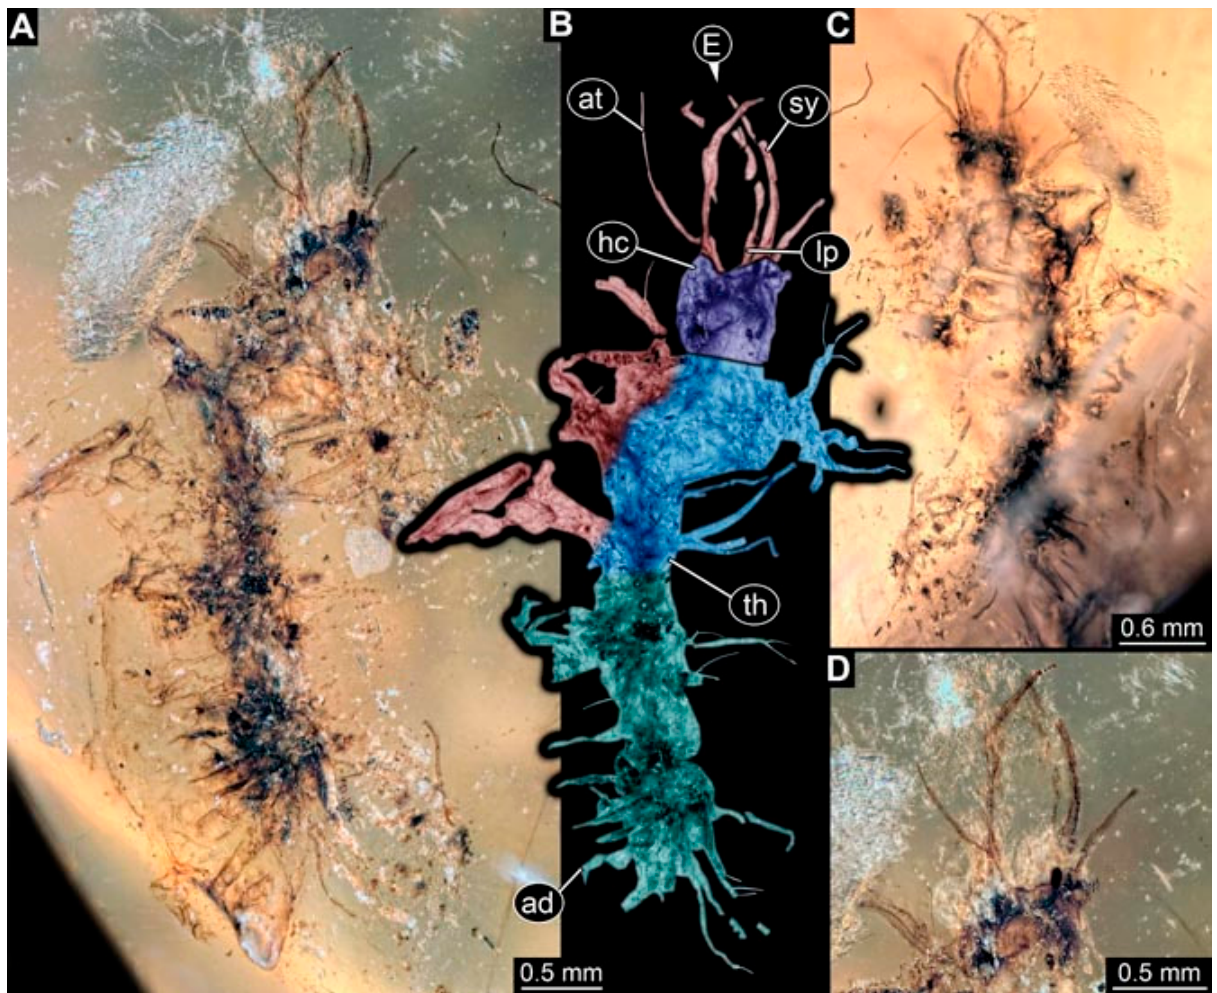
Figure 20. Specimen 4841 (PED 0433); Myanmar amber. ( A ) Dorsal view. ( B ) Dorsal view, colour- marked. ( C ) Ventral view. ( D ) Close-up of head capsule in dorsal view. Abbreviations: ad = abdomen; at = antenna; hc = head capsule; lp = labial palp; sy = stylet; th = thorax.